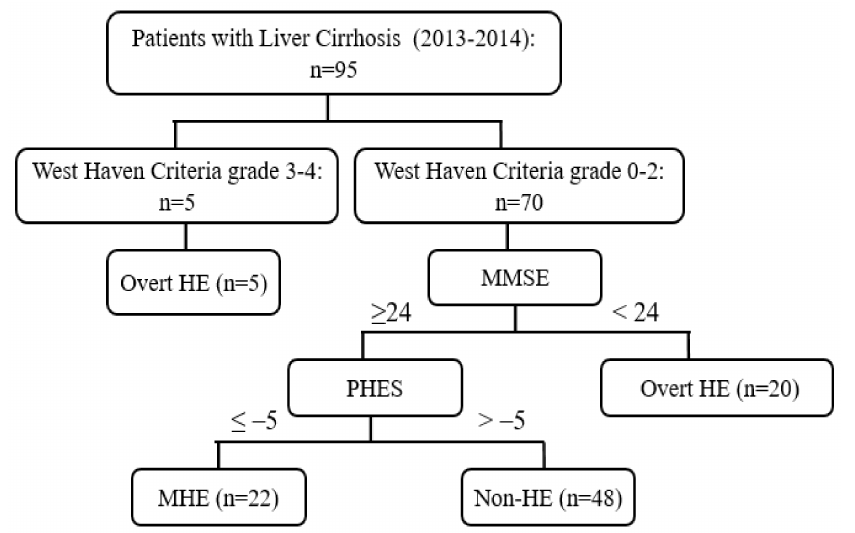
Figure 1. Flowchart of study patients. HE, hepatic encephalopathy; MMSE, mini‑mental state exam‑ ination; PHES, psychometric hepatic encephalopathy score; MHE, minimal hepatic